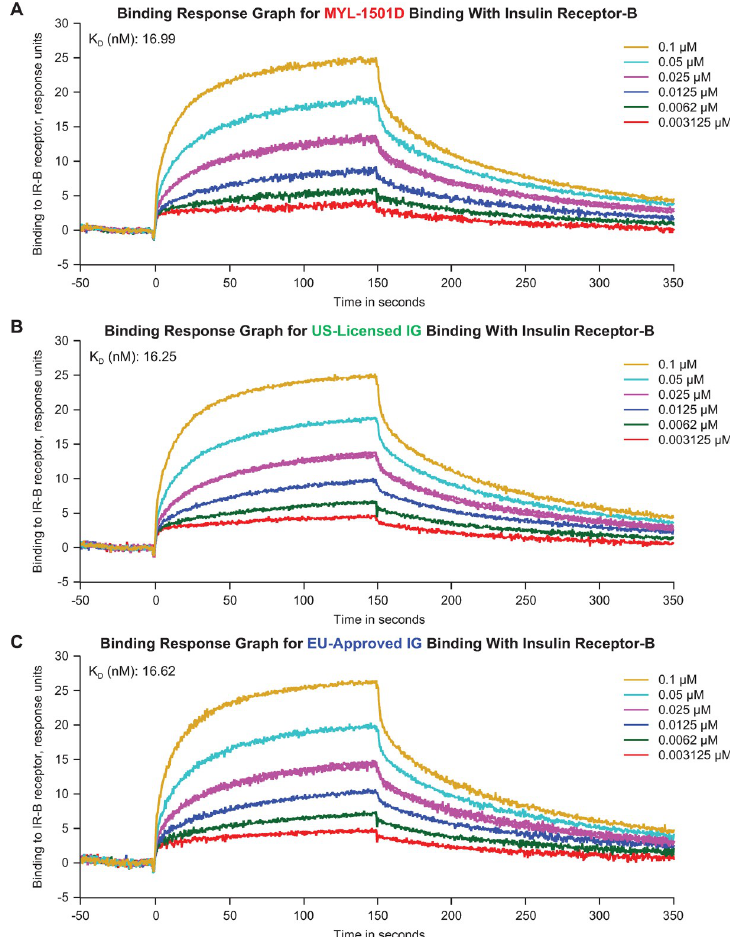
Fig 7. Representative binding response graphs of the insulin receptor-B (long-form) kinetic binding assay. ( A) MYL-1501D, (B) US-Licensed Insulin Glargine, and (C) EU-Licensed Insulin Glargine. Each lot was analyzed over 6 concentrations, and kinetic parameters were evaluated by 1:1 interaction model using global fit. Each lot was analyzed 3 independent times, and mean K D value was reported. K D , equilibrium dissociation constant. (Table 2), establishing the monodisperse higher-order folded protein structure of insulin glar- gine and indicating similarity in overall molecular size and shape across all samples.